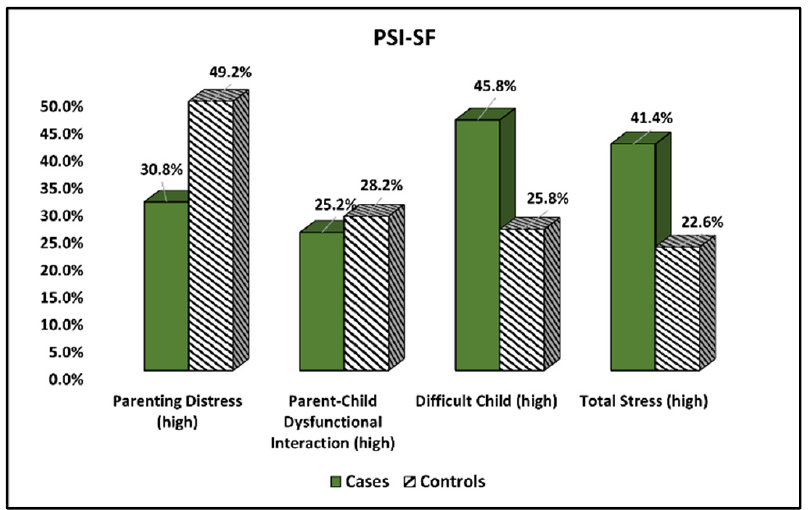
Figure 2. Comparison of PSI-SF survey results between cases and controls.